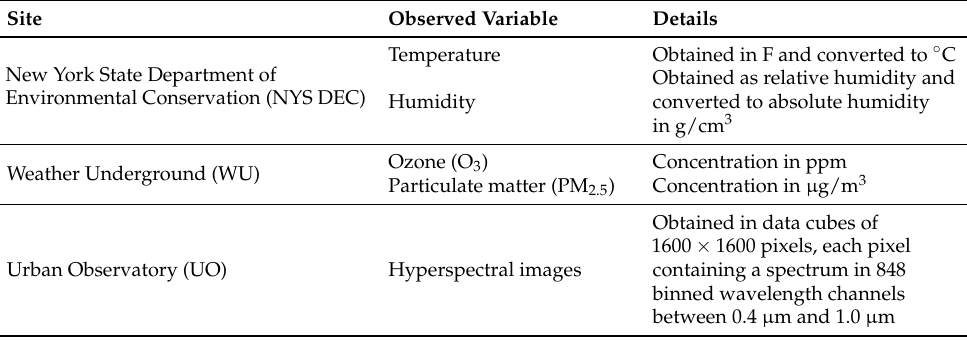
Figure 4. Map of NYC showing the locations of the Urban Observatory’s hyperspectral imaging system (red triangle), the vegetation and buildings used in this study (green square), the New York State Department of Environmental Conservation’s air quality monitoring sites (blue circles), and the Weather Underground network of air quality sensors (black crosses). Table 1. Collected variables from the observation sites shown in Figure